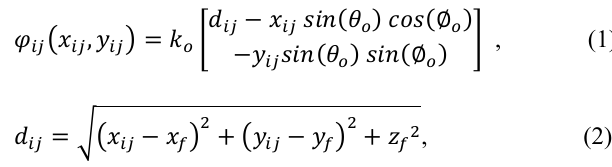
Figure 3: The detailed construction of the configuration 13×13 FF-focused transmitarray.